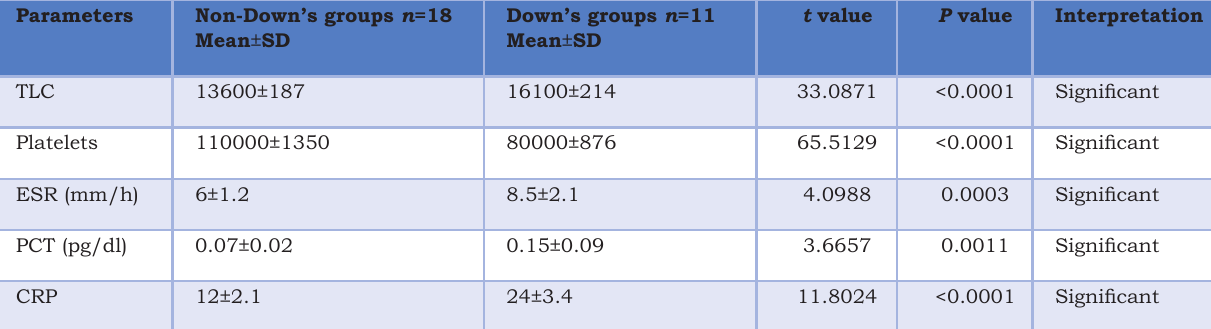
Table 5: The comparison of sepsis parameters at admission Parameters